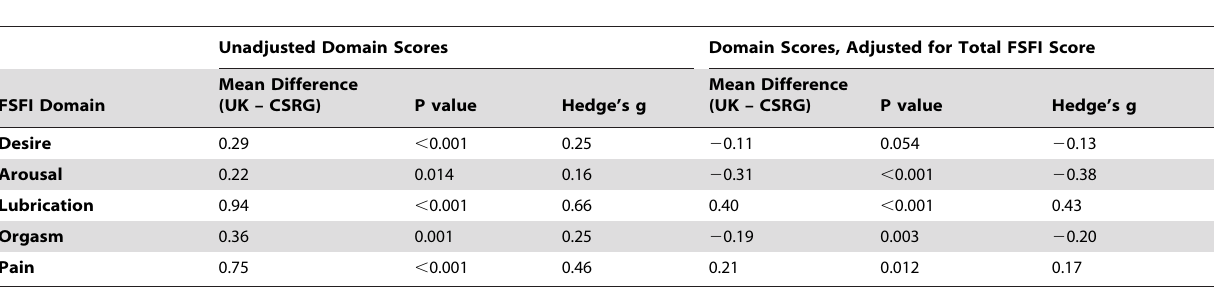
Table 4. Comparison of FSFI domain scores between sexually active women with systemic sclerosis Patients and sexually active women from a UK general population sample; unadjusted and adjusted for total FSFI score.